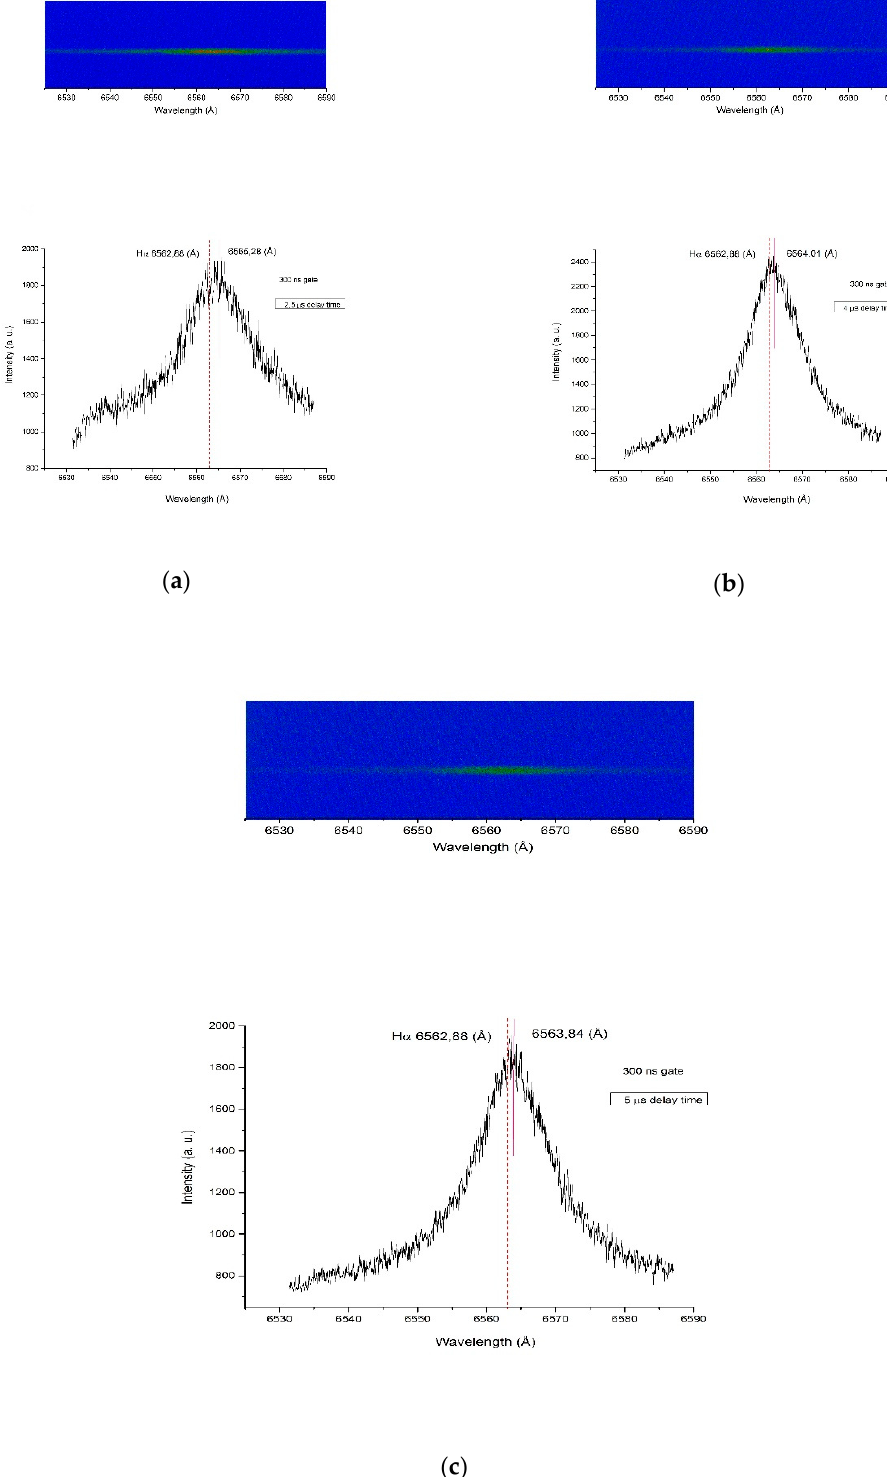
Figure 4. Spectrally resolved images of the plasma (with a gate time of 300 ns) at ( a ) 2.5 µ s, ( b ) 4 µ s, and ( c ) 5 µ s after laser pulse with a wavelength range from 6530 to 6590 Å and spectra obtained from these images of the H α -line in LSP conditions.